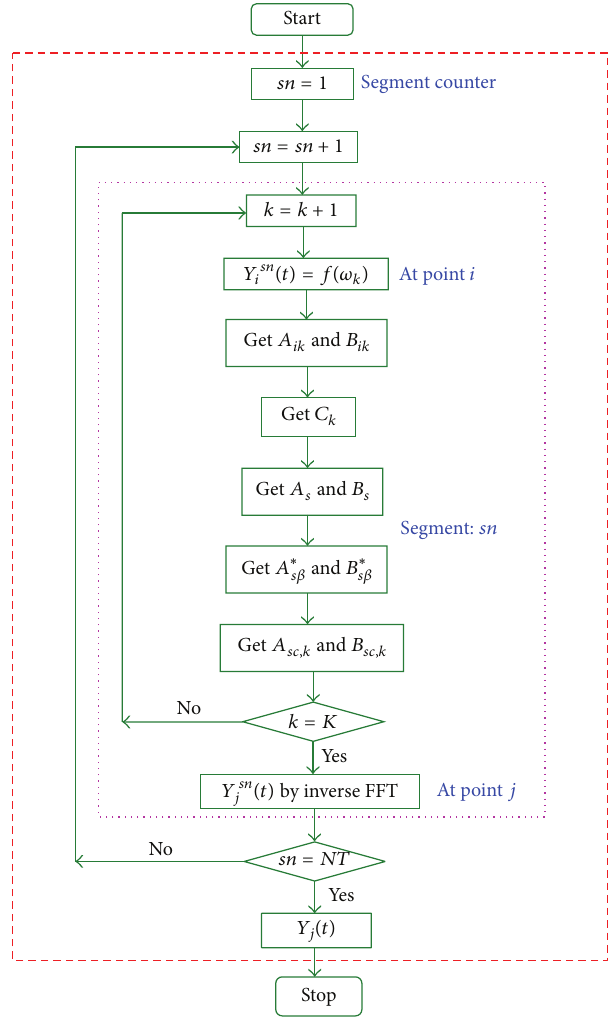
Figure 2: Flowchart of conditional